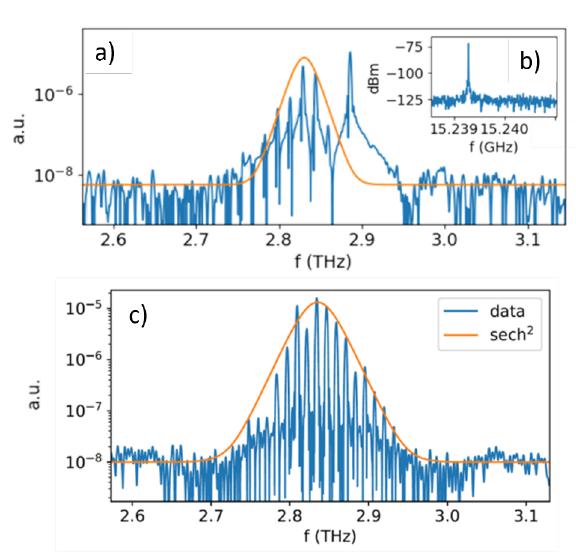
Figure 2. a) Free running Spectrum of a coupled waveguide ring laser with 800 µ m radius driven in CW at 1.045A and kept at 37K with its electrically measured beatnote (b). c) Spectrum of a 1 mm radius double waveguide ring laser driven at 700mA in CW and kept at 35K. The device is strongly injected ( ∼ 35 dBm) at the repetition frequency (12.45 GHz).